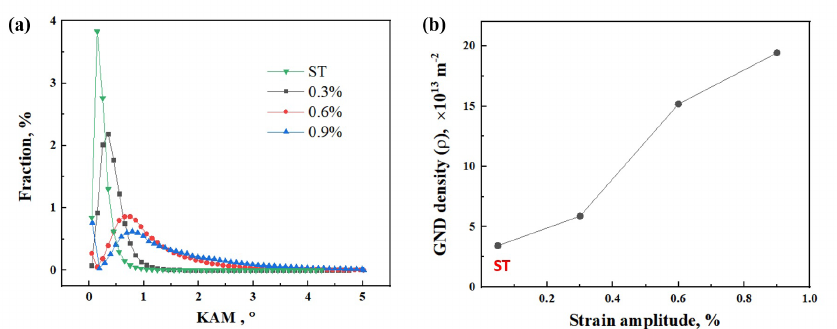
= 0.3%; 0.6%; 0.9%, (a1)-(c1) IPF maps, (a2)-(c2) KAM maps. t